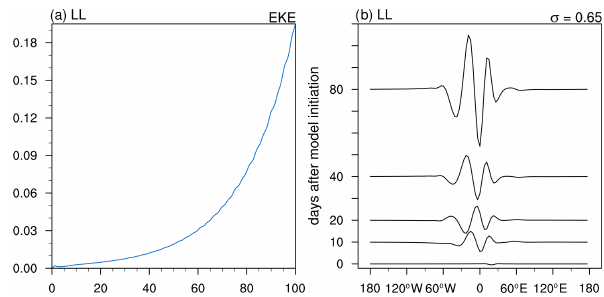
Figure 14. Results for the long-lived wave packet simulation with added sponge region: (a) time series of the globally averaged EKE (Jkg − 1 ) and (b) streamfunction (10 5 m 2 s − 1 ) averaged over 10–20 ◦ N at σ = 0 . 65 and plotted as a function of longitude for se- lected